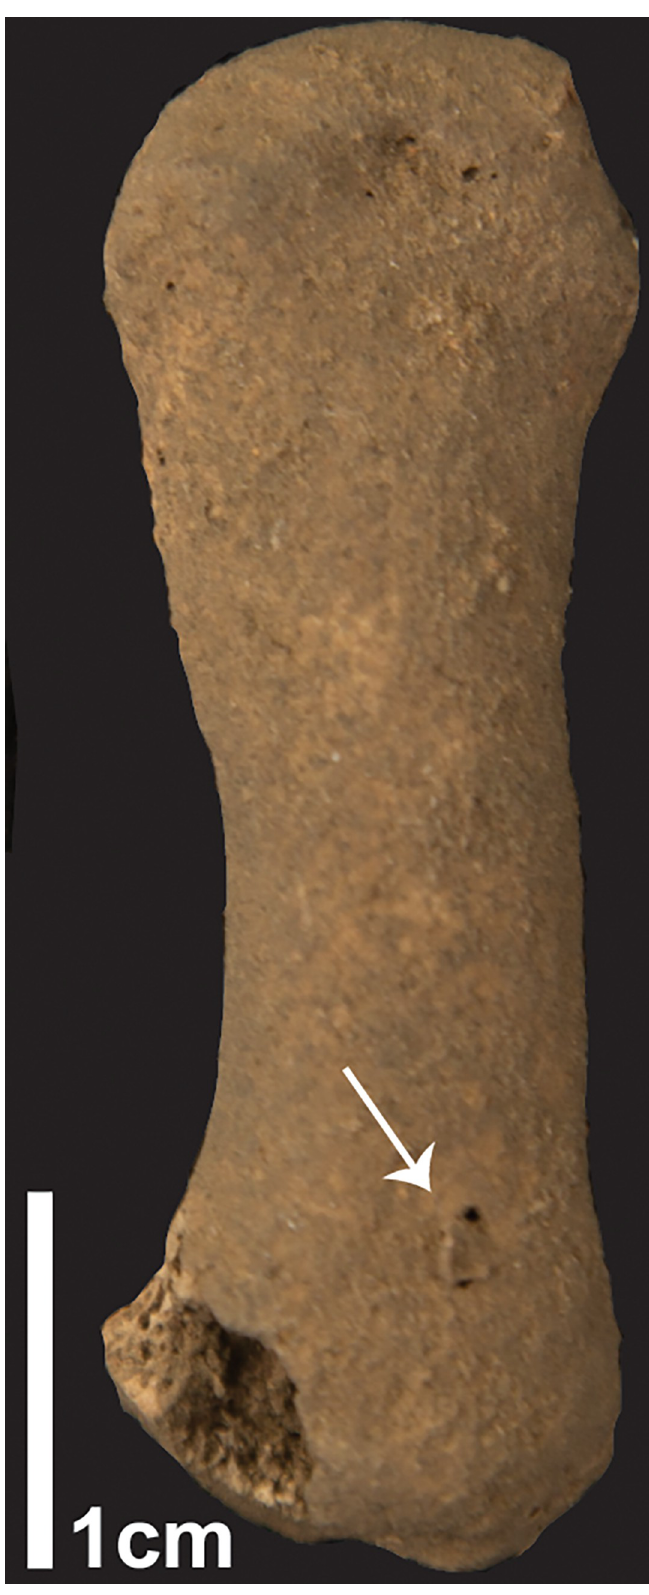
Fig 8. Right first metacarpal from DE B2. Perforation and unidentified intrusive object (white arrow). https://doi.org/10.1371/journal.pone.0267635.g008 PLOS ONE | https://doi.org/10.1371/journal.pone.0267635 August 24,